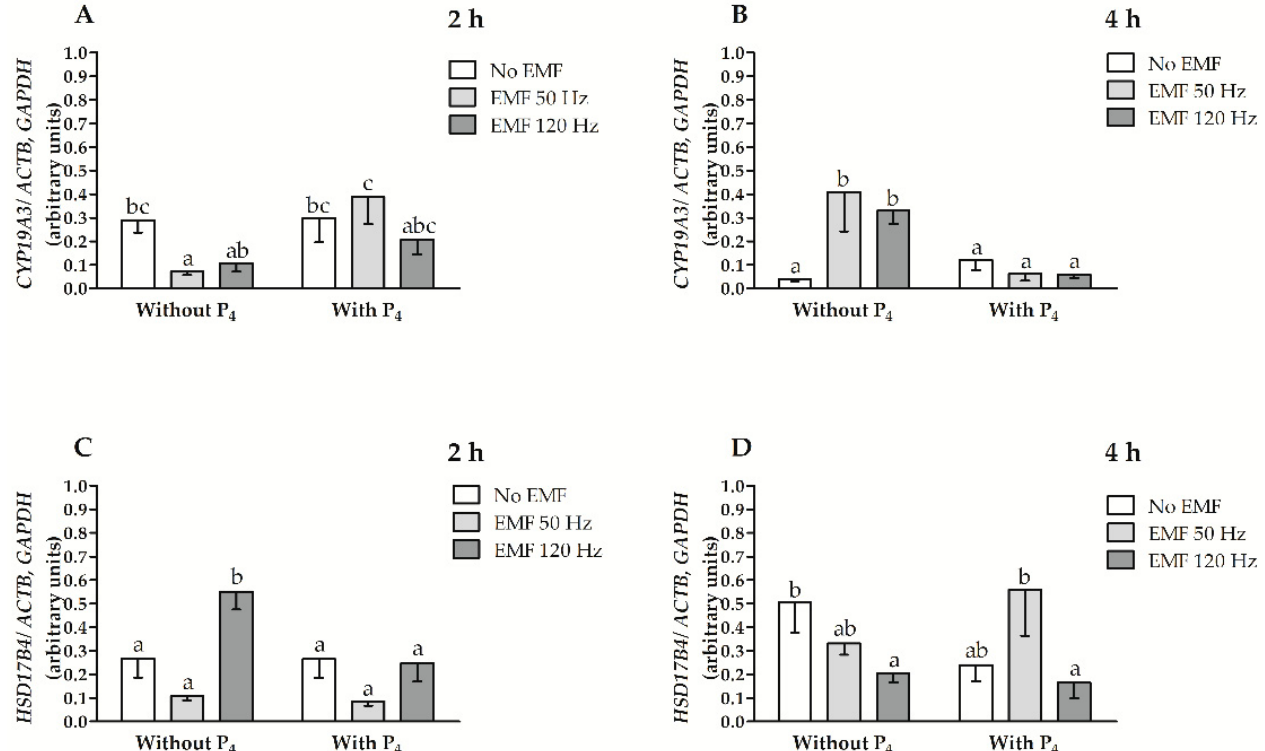
Figure 1. The relative abundance of cytochrome P450arom ( CYP19A3 ) ( A , B ) and 17 β hydroxysteroid dehydrogenase ( HSD17B4 ) ( C , D ) mRNA transcript abundance in myometrial slices collected from pigs during days 15–16 of early pregnancy and treated in vitro with EMF at 50 and 120 Hz for 2 h ( A , C ) and 4 h ( B , D ) of incubation with or without the inclusion of P 4 in the culture medium. Data presented as mean ± SEM. Lower-case letters (a–c) above bars indicate statistically significant differences at p ≤ 0.05 (multi-way